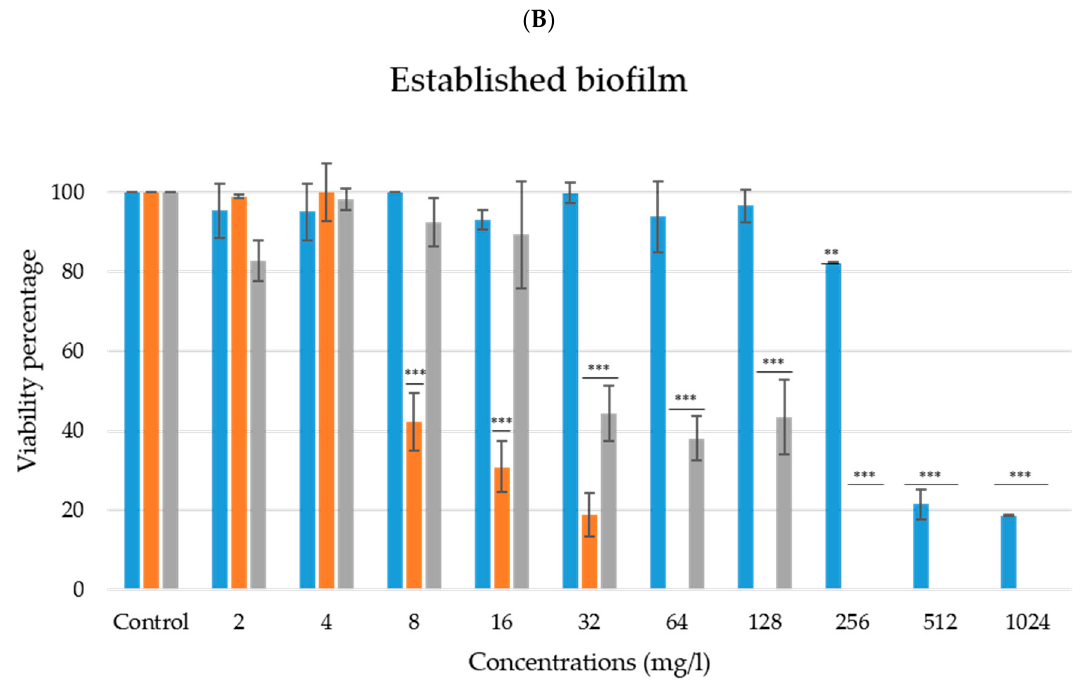
Figure 2. ArCO 2 G 1 (SNMe 3 I) 2 ( 1 )—blue, ArCO 2 G 2 (SNMe 3 I) 4 ( 2 )—orange, ArCO 2 G 3 (SNMe 3 I) 8 ( 3 )—grey. ( A ) Antifungal activity and inhibition of the formation of C. albicans biofilm in the biofilm formation experiments, ( B ) Antibiofilm activity against stablished biofilms in the established biofilm experiments. p values: * p < 0.05, ** p < 0.01, *** p < 0.001.